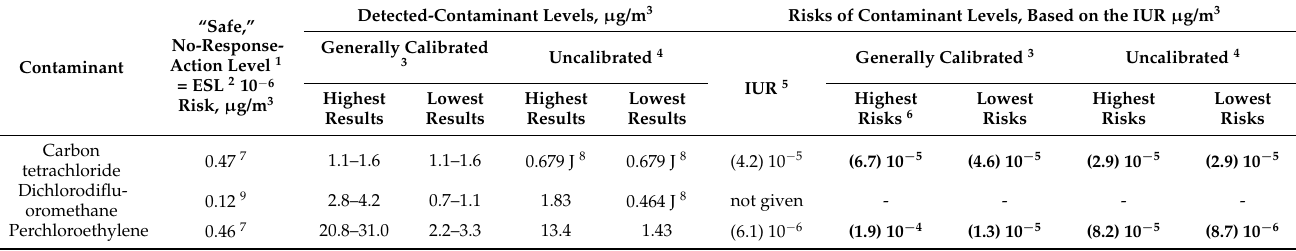
Table 8. Violations of the Third Safety Benchmark, Based on Inhalation Unit Risk (IUR), Indoor-Air Passive Samplers, Former Naval Ordnance Testing Station, Pasadena, California (NOTSPA). Bold =